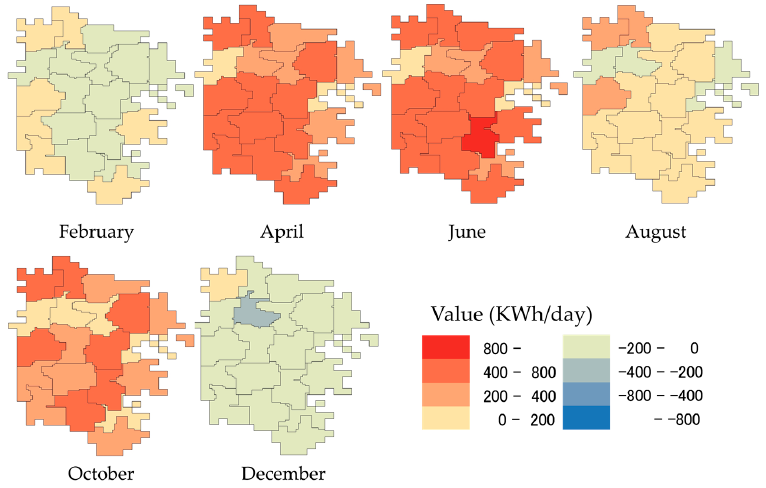
Figure 8. Storage sufficiency (per 250-m grids) of the SA clusters optimized in June.